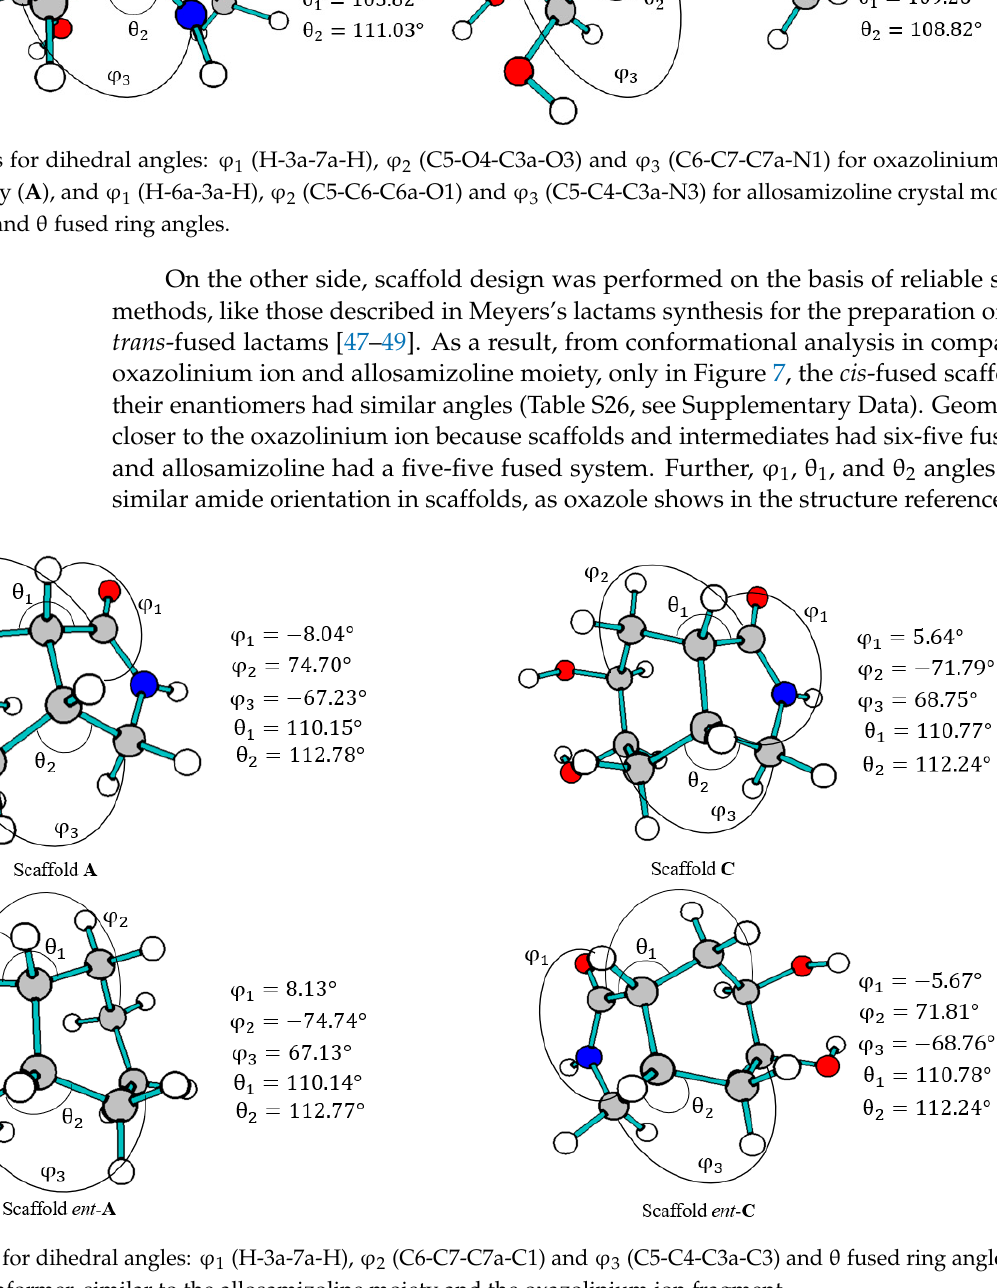
Figure 6. Values for dihedral angles: ϕ 1 (H-3a-7a-H), ϕ 2 (C5-O4-C3a-O3) and ϕ 3 (C6-C7-C7a-N1) for oxazolinium ion minimum energy ( A ), and ϕ 1 (H-6a-3a-H), ϕ 2 (C5-C6-C6a-O1) and ϕ 3 (C5-C4-C3a-N3) for allosamizoline crystal moiety ( B , PDB: 2A3E) and θ fused ring angles.